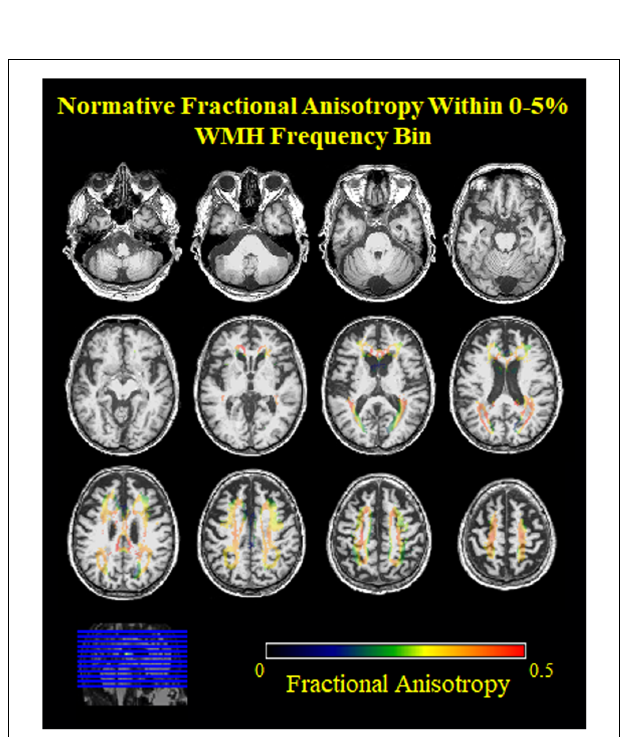
FIGURE 3 | Normative FA values from young adults within the low frequency voxels for WMH in older adults. Note, the low FA (blue, green) values on the edges of the 0%–5% WMH bin, indicating inclusion of nearby gray